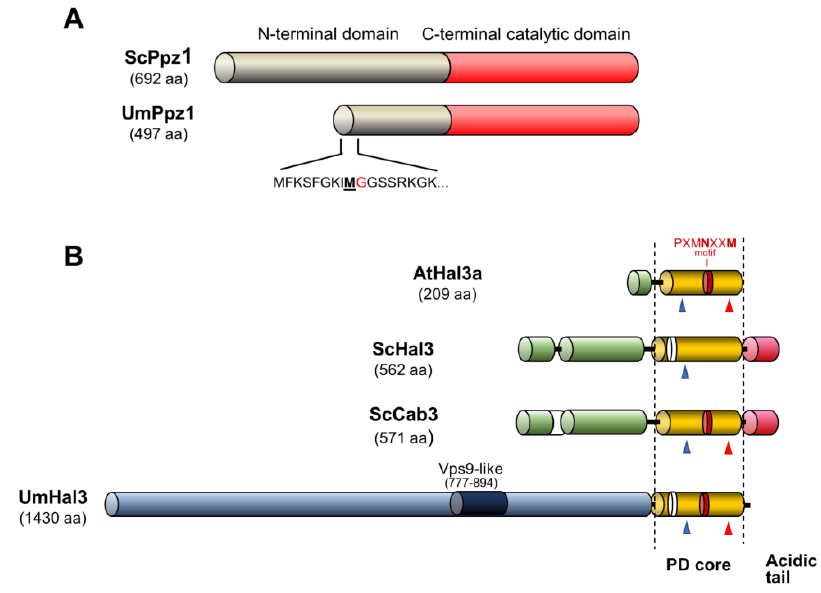
Figure 1. Comparison of the structures of S. cerevisiae and U. maydis Ppz1 and Hal3 proteins. Panel A . ScPpz1 and UmPpz1 structures. Note the shorter N-terminal extension in UmPpz1, the absence of a Gly at position 2, and the presence of a Met followed by a Gly (red) at positions 9 and 10. Panel B . Comparison of A. thaliana Hal3a, S. cerevisiae Hal3 and Cab3 and U. maydis Hal3 (UmHal3). The His and Cys residues required for PPCDC activity are indicated as blue and red arrowheads, respectively. The red section corresponds to the PXMNXXM motif. To note the absence in UmHal3 of the acidic C-tail found in both S. cerevisiae proteins. The length of each protein is indicated in parentheses. Scales in panel A and B are different.